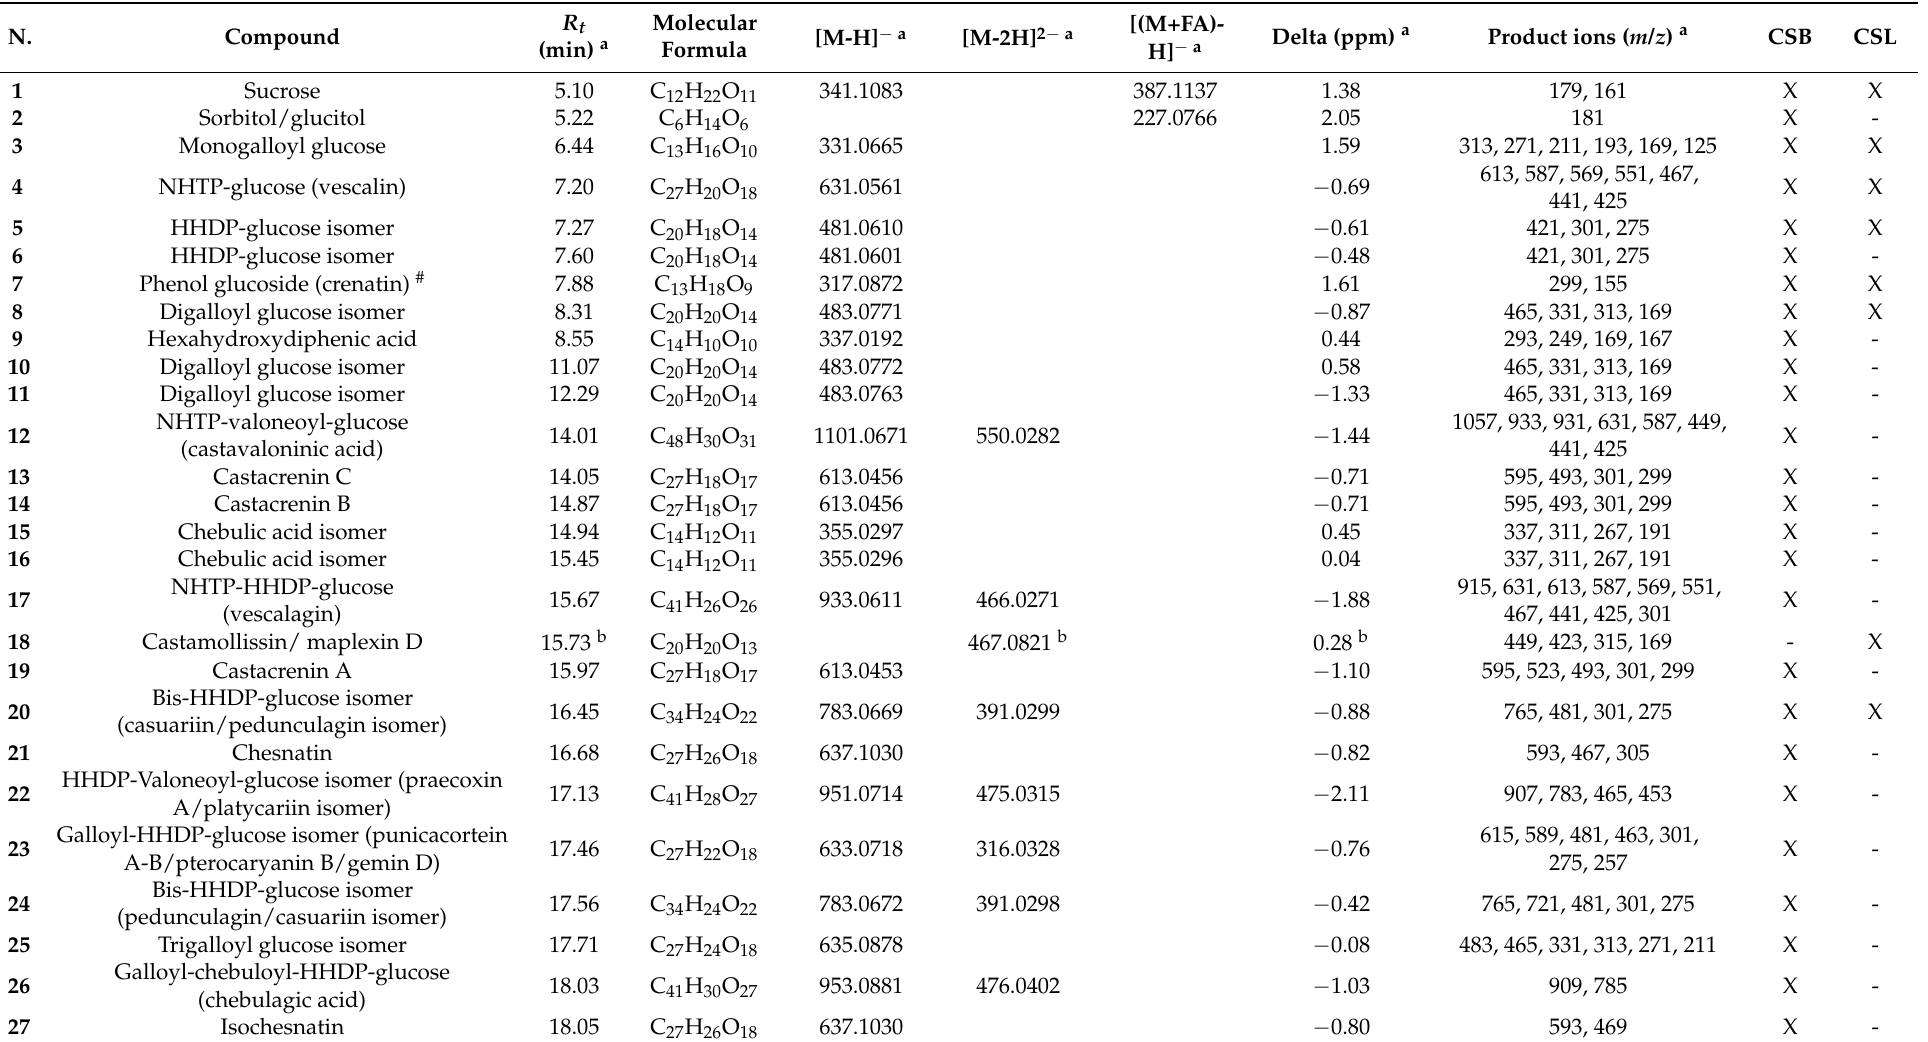
Table 3. Metabolites putatively identified in the MeOH extract of C. sativa (Marrone di Roccadaspide) burs (CSB) and leaves